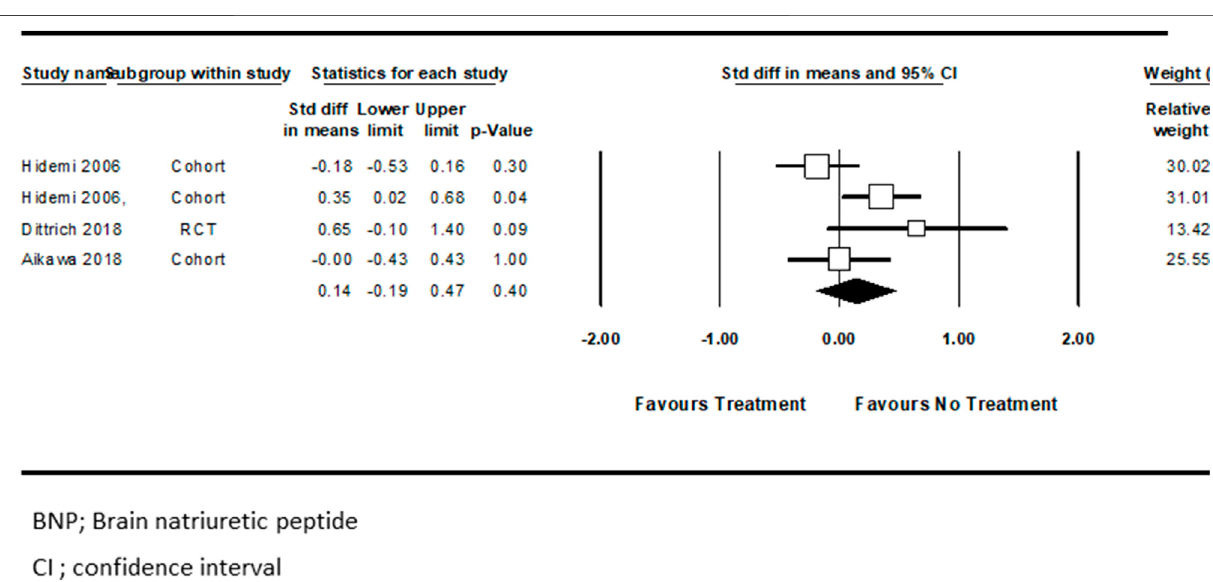
Frontiers in Pharmacology |